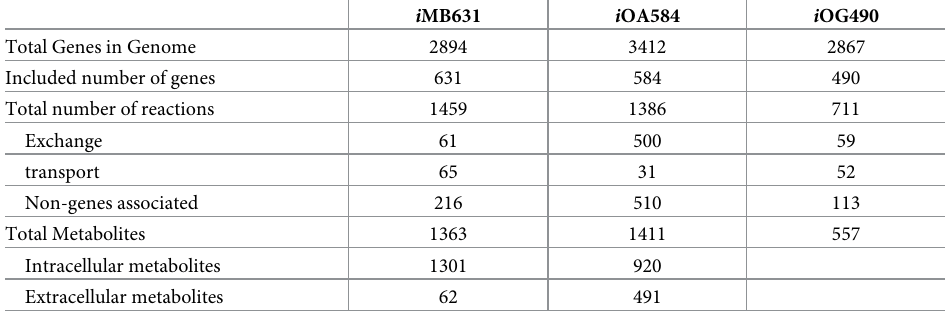
Table 1. Comparison of general characteristics of i MB631 with previously reconstructed networks of halophiles, i OA584 and i OG490 representatives of bacterial and archaeal halophilic models respectively.